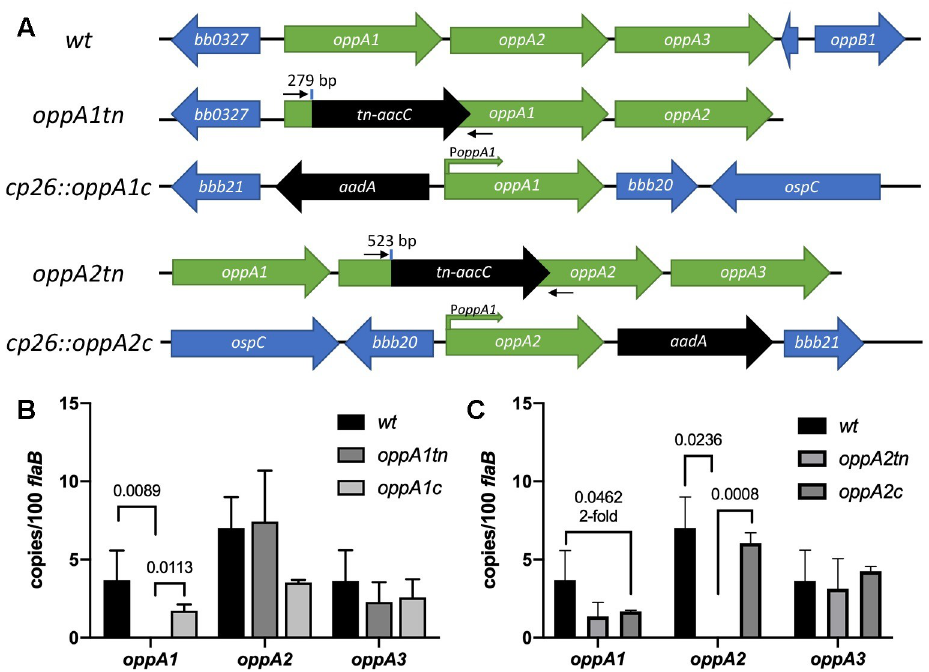
Fig 1. In vitro characterization of oppA1 and oppA2 mutants and complements. (A) Schematics of the wt , oppA1tn and oppA2tn mutants and the corresponding complements in cp26. The transposon ( tn ) insertion sites (bp of coding sequence) are indicated. aacC and aadA confer gentamycin and streptomycin resistance, respectively. qRT-PCR primers specific to the tn insertion site are noted with small black arrows. (B-C) Transcript copy numbers of oppA1-3 (mean ± SEM, normalized to flaB ) in (B) wt , oppA1tn , and oppA1c and (C) wt , oppA2tn , and oppA2c determined from triplicate biological replicates and quadruplicate technical replicates. Statistical analyses were performed using unpaired Student’s t test.